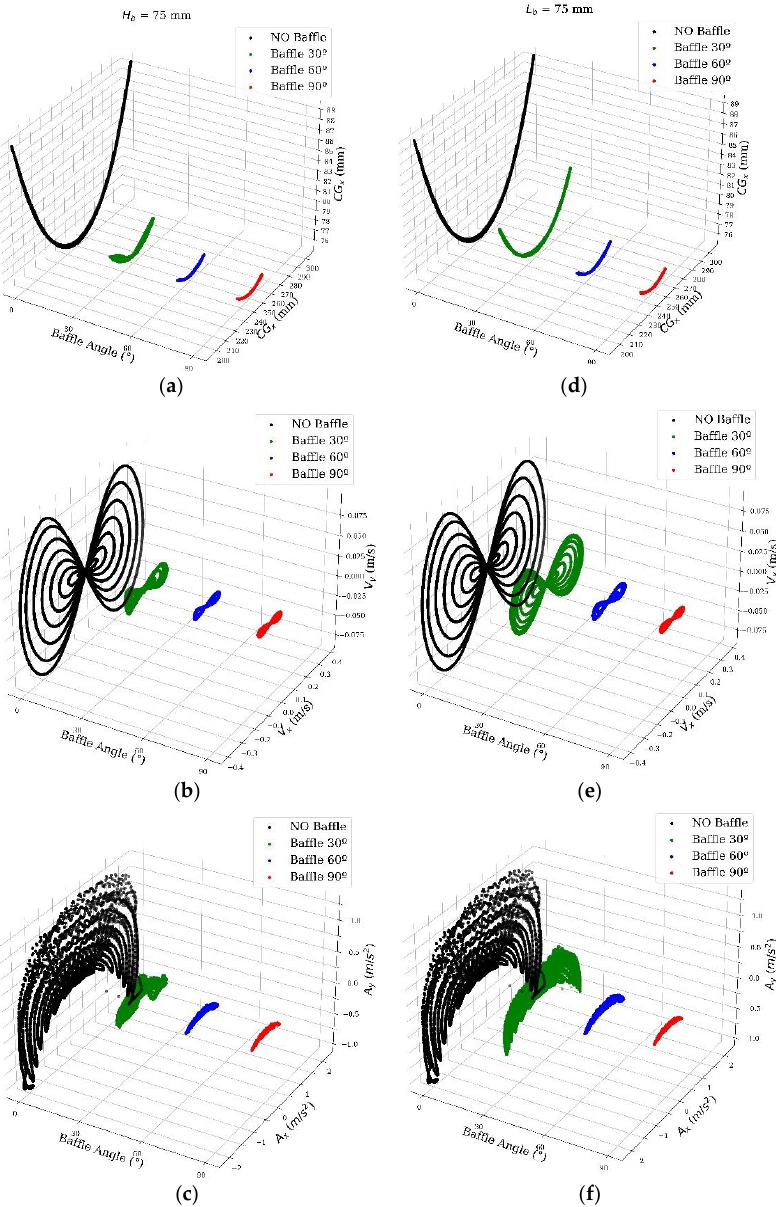
Figure 8. X and Y scattered plot for each angle. Left column for fixed H b = 75 mm ( a ) CG position, ( b ) velocity and ( c ) acceleration and right column for fixed L b = 75 mm ( d ) CG position, ( e ) velocity and ( f ) acceleration.